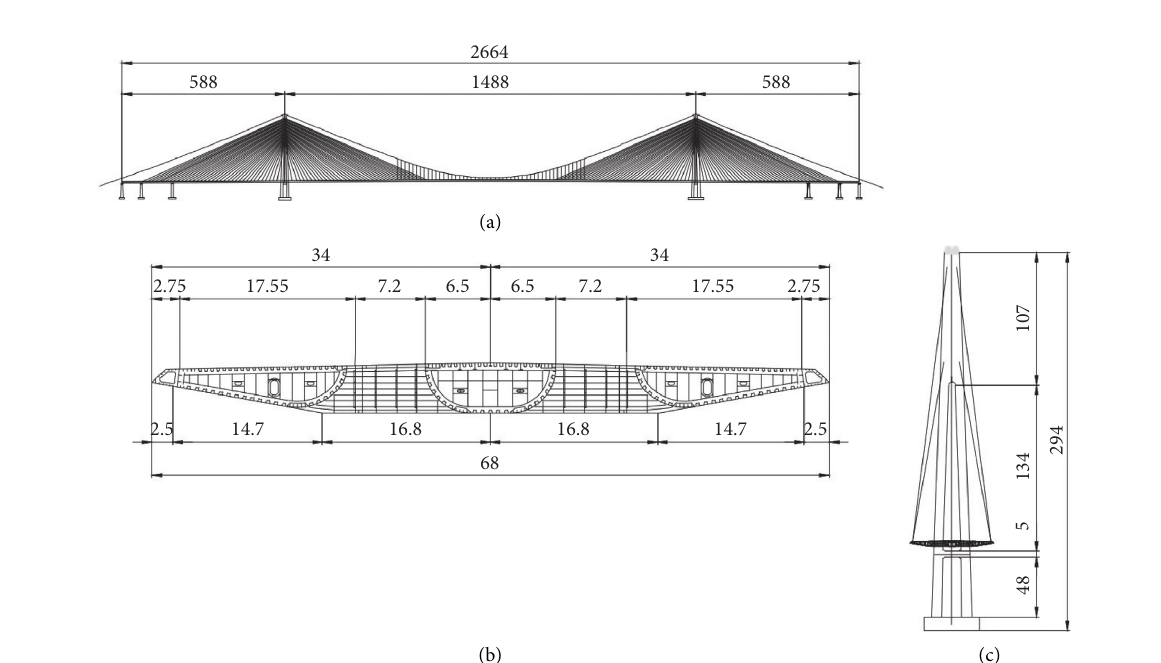
Figure 2: Bridge layout (unit in m). (a) Elevation layout of the main bridge. (b) Cross section of the girder. (c) Elevation layout of the bridge tower.